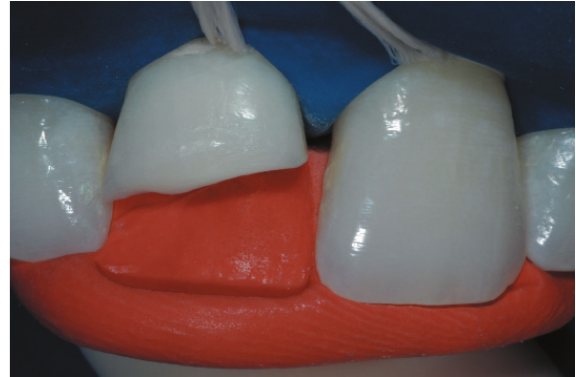
differences at each tooth region